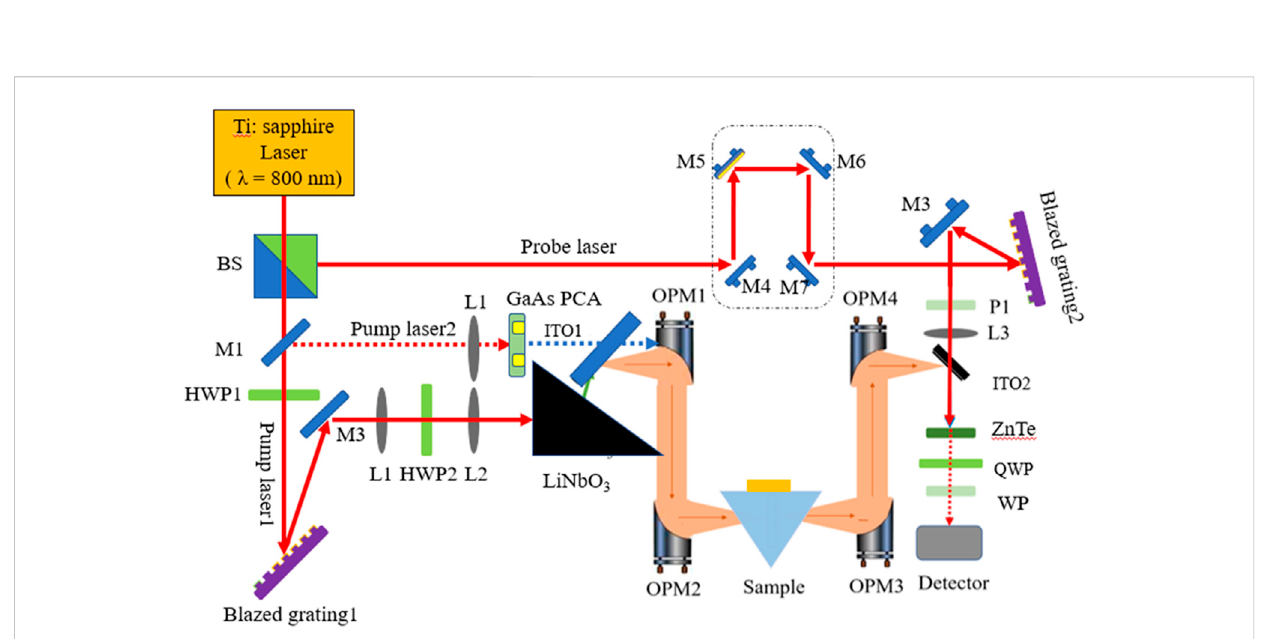
FIGURE 2 The schematic diagram of the design optical path of THz-ATR spectrometer for liquid biological